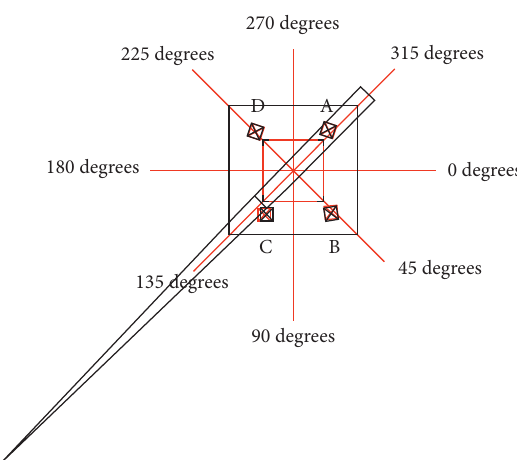
Figure 5: Schematic diagram of the angles of the tower